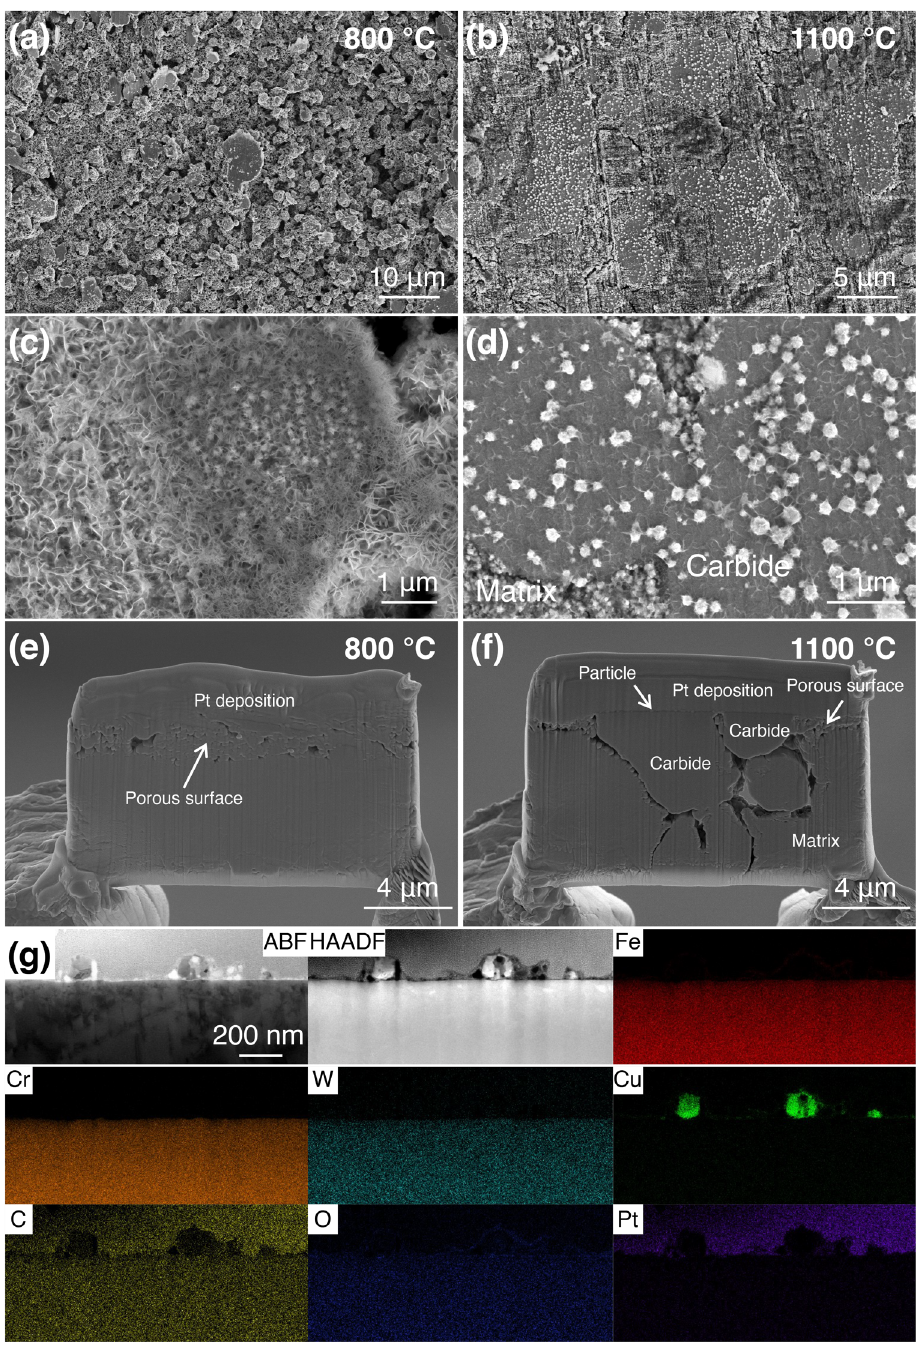
Fig. 7 Sur fi cial and cross-sectional characterisations of the corrodes surfaces. SEM images of the surface regions of the 16Cr steel samples quenched from a 800 and b 1100 °C after immersion in the 0.5 M H 2 SO 4 solution for 3 h. Magni fi ed SEM images of the corroded surfaces of the c martensitic matrix and d carbide particles in the 1100 °C sample. Cross-sectional SEM images of the e 800 °C and f 1100 °C samples obtained during FIB sampling. g STEM observations and the corresponding EDS mapping data obtained for the sample quenched from 1100